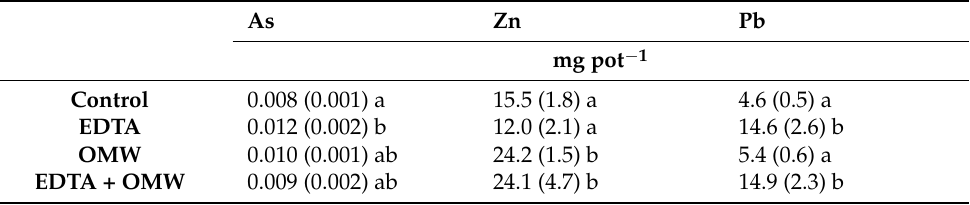
Table 2. Total uptake of As, Zn and Pb by H. annuus for different treatments. Comparisons performed by Tukey’s HSD test ( p ≤ 0.05) are demonstrated with lowercase letters and are valid within each element. The presence of a common letter implies no significant difference. OMW: olive mill wastewater. The standard errors of means are given in parentheses.